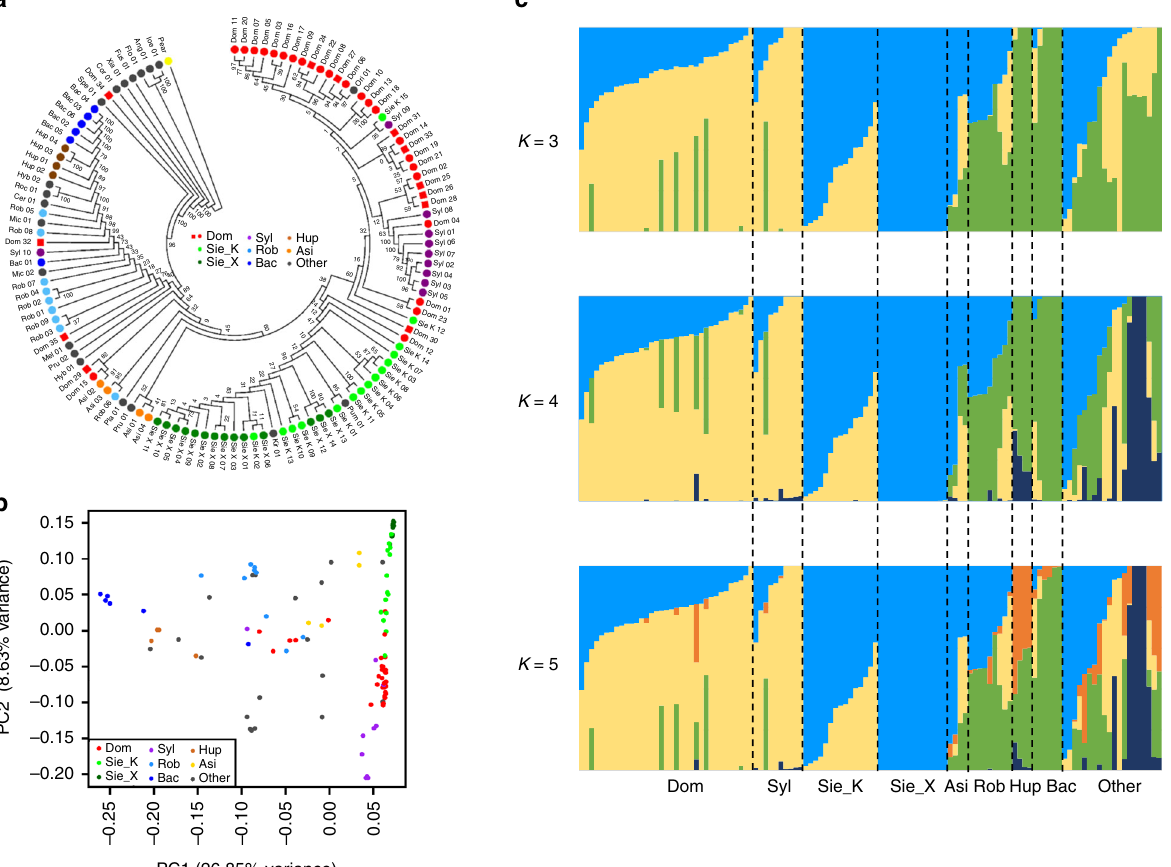
Fig. 1 Population structure of 117 domesticated and wild apples. a Neighbor-joining phylogenetic tree constructed using SNPs at fourfold degenerate sites. Each species group is color coded, with red squares representing rootstocks and red dots scions. b Principal component analysis ( PCA ) of the 117 apple accessions. c Bayesian model-based clustering of the 117 apple accessions with the number of ancestry kinship ( K ) from 3 to 5. Each vertical bar represents one apple accession and the x axis shows different apple accessions. Each color represents one putative ancestral background and the y axis quanti fi es ancestry membership. Asi M. asiatica , Bac M. baccata , Dom M. domestica , Hup M. hupehensis , Other other wild species, Rob M. robusta , Sie_K M. sieversii in Kazakhstan, Sie_X M. sieversii in Xinjiang, Syl M.